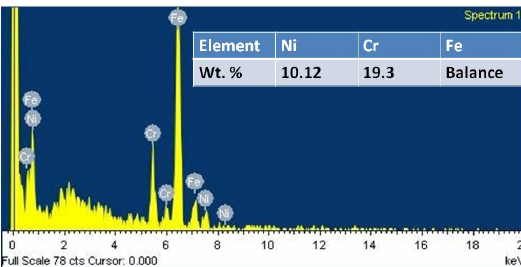
Fig. 4 EDS patterns and compositional micro analysis (inset) of 40h milled powder of alloy A. Table 1: Average Size Particle of Milled Powder (Alloy A) at Different Milling Times